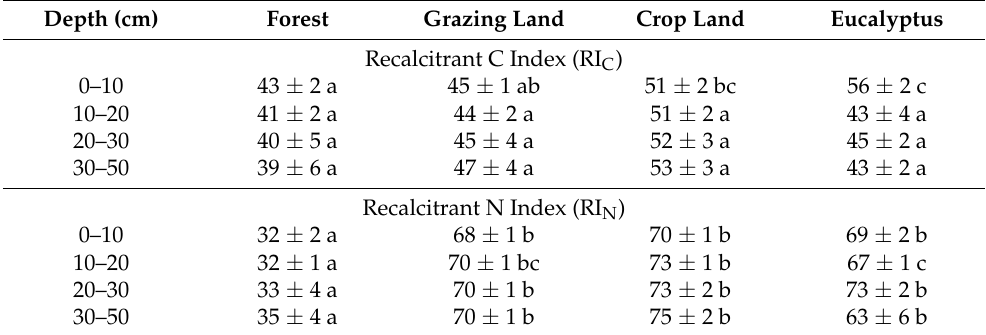
Table 4. Recalcitrant index of SOC and N in different soil depths in forest, grazing and crop lands and eucalyptus